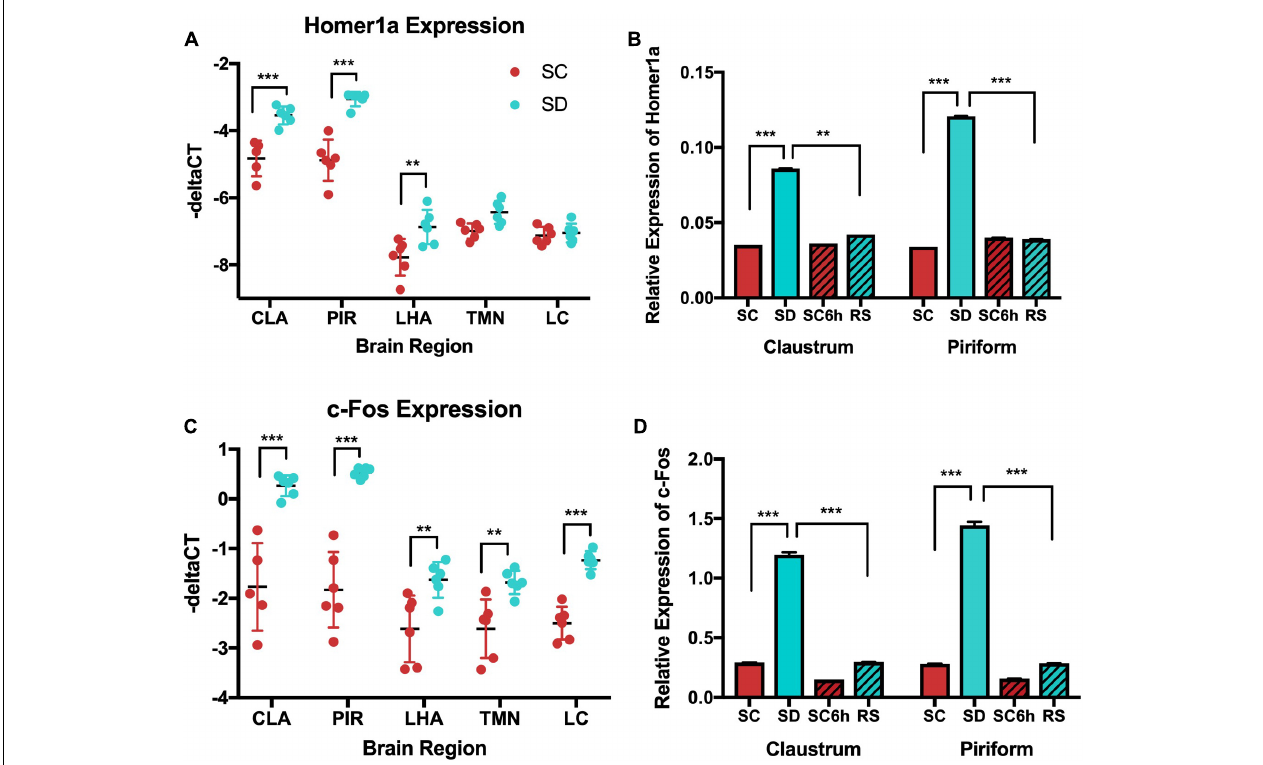
in these mice ( p = 0.002) ( Figure 7C and Supplementary Table S4 ); increases in c-fos with sleep deprivation based on qPCR were generally larger in the claustrum and piriform cortex. Similar data was observed by c-Fos immunostaining of these regions ( Figure 5